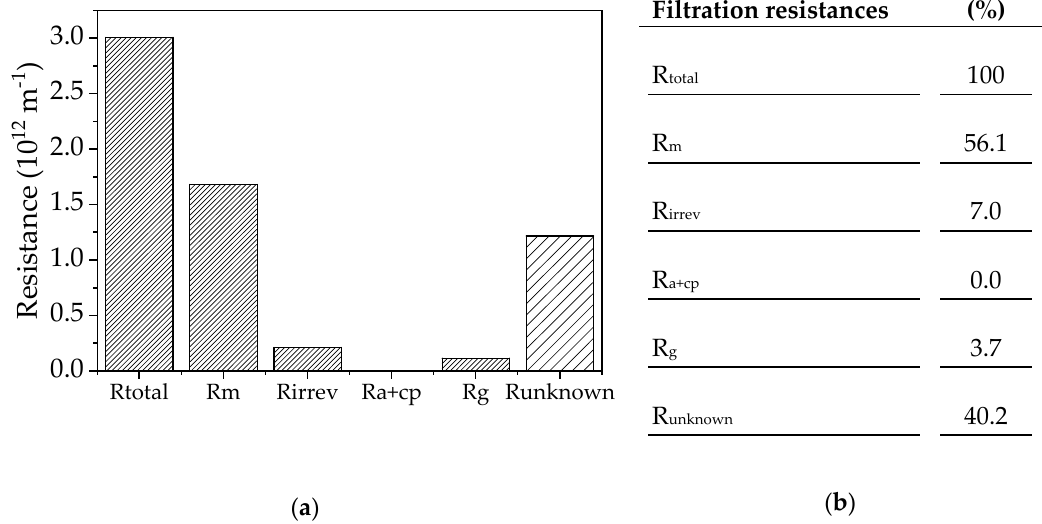
Figure 5. ( a ) Resistance values calculated according to the resistance-in-series model. R total = total resistance; R m = membrane resistance; R irrev = irreversible resistance still present after cleaning; R a+cp = resistance caused by adsorption and concentration polarization of the substrate solution; R g = resistance of the gel layer caused by filtration of the enzyme solution; R unknown = unknown resistance. ( b ) Resistances proportional to the total resistance.